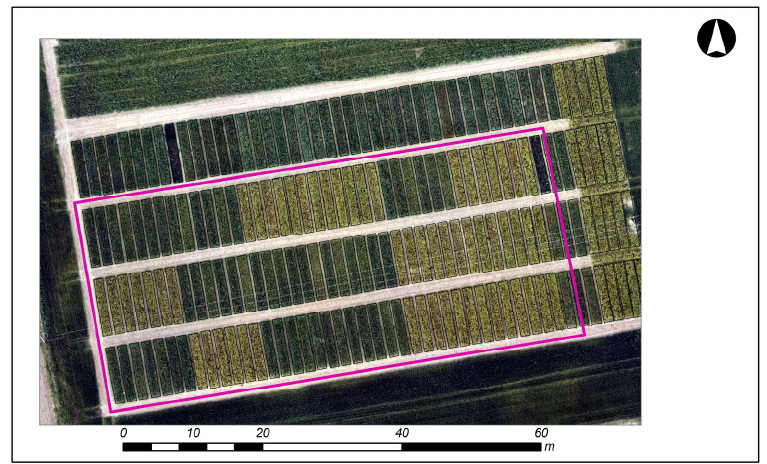
Figure 3. RGB UAV orthophoto (GSD 2.0 cm) based on SONY UMC R10C photos captured on May